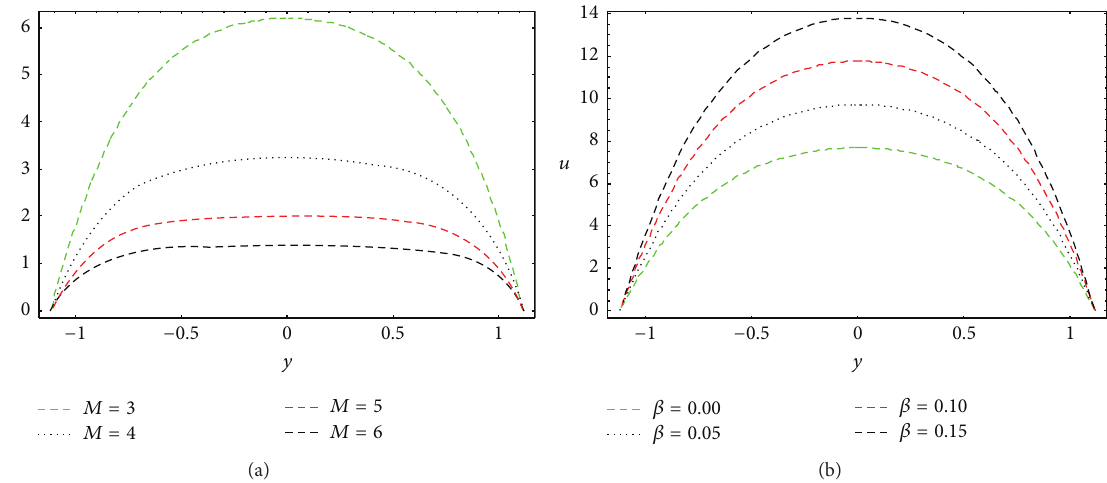
Figure 1: Variation on 𝑢 when 𝐸 1 = 1 , 𝐸 2 = 0.2 , 𝐸 3 = 0.5 , 𝜀 = 0.2 , 𝛿 = 0.01 , 𝑡 = 0.2 , 𝑅 = 0.01 , 𝜆 1 = 0.1 , 𝜆 2 = 0.05 , and 𝑥 = 0.3 plotted for (a) for different values of 𝑀 and (b) different Burger’s fluid parameter 𝛽